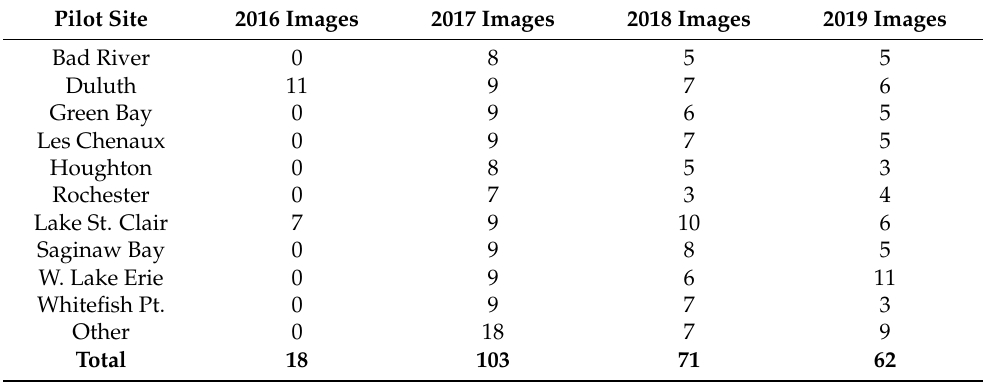
Table 2. List of Pilot Sites and RADARSAT-2 Images obtained within the growing season of each year. Pilot